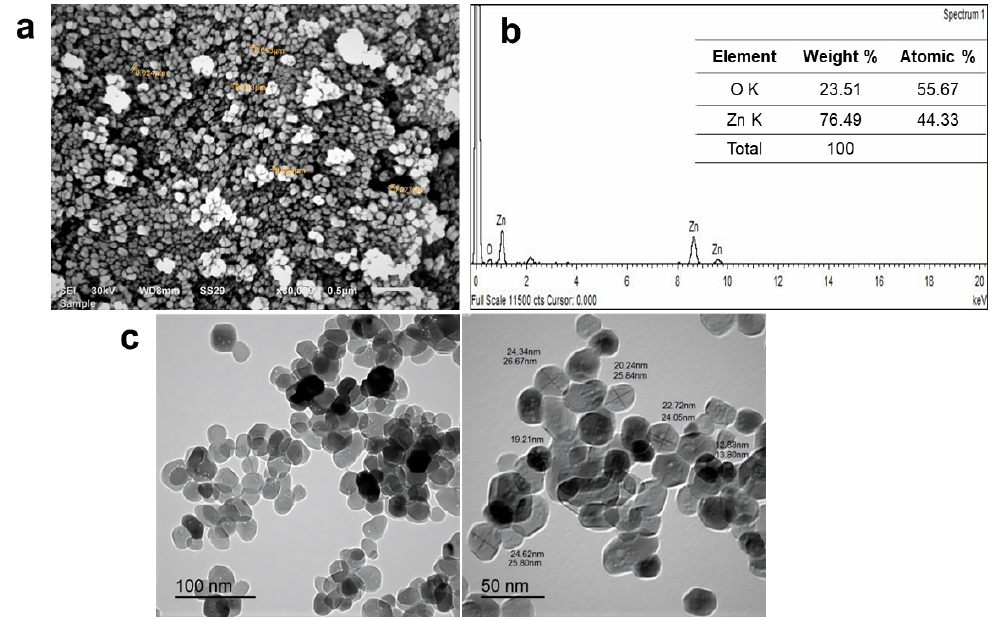
Figure 3. ( a ): SEM micrograph, ( b ): EDX spectrograph, and ( c ): TEM micrographs at different magnification powers of ZnO NPs synthesized from A. niger. The ζ -potential and size distribution range of ZnO NPs were determined by the dy- namic light scattering (DLS) technique (Figure 4). The average polydispersity index (PDI) value of ZnO NPs was 0.186 ± 0.05, which is considered an optimum value with adequate size distribution (Figure 4a). The hydrodynamic size of ZnO NPs was also evaluated using DLS (Figure 4a), showing an average diameter equal to 225.46 ± 3.27 nm. The value of ζ - potential critically determines the colloidal stability of ZnO nanosuspension after proper dilution with distilled water. Generally, the optimum value of ζ -potential ranges from +40 to − 40 mV to ensure adequate dispersibility with no risk of aggregation or flocculation [22–24]. The surface charge of biosynthesized ZnO NPs from A. niger is equal to 26.6 ± 0.56 mV (Figure 4b).